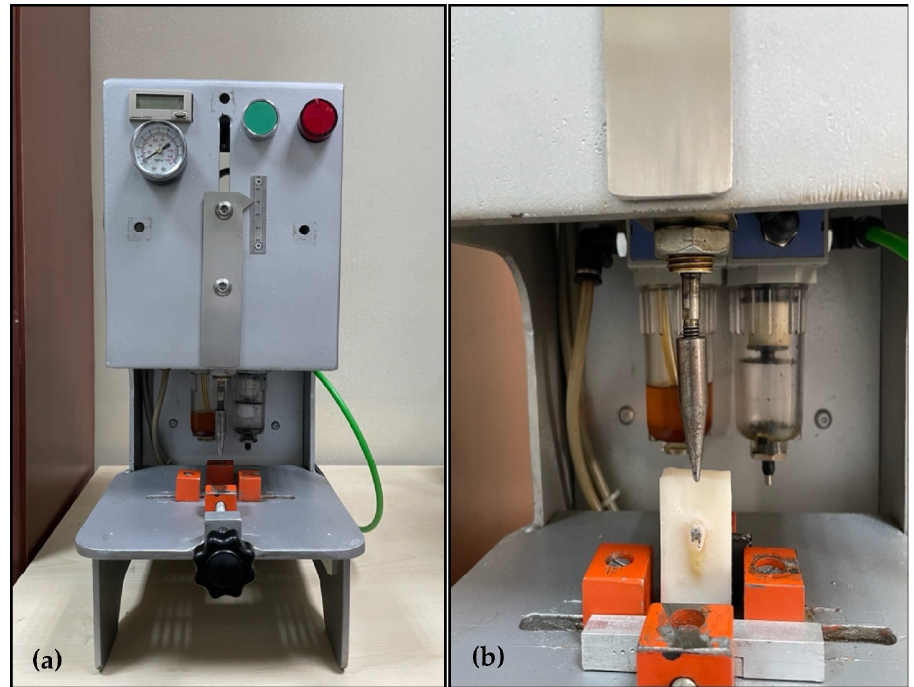
Figure 2. General representation of the fatigue machine ( a ) and the sample testing position ( b ).